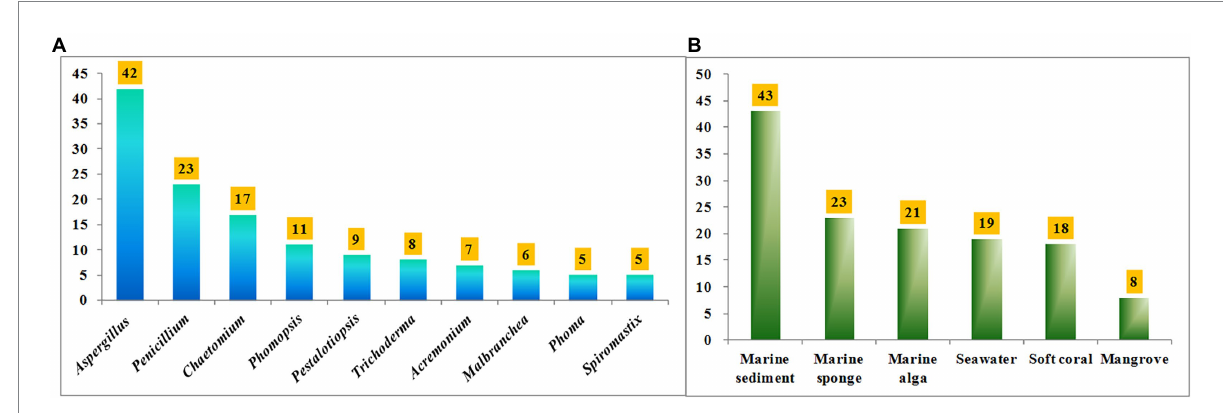
FIGURE 11 (A) Numbers of halometabolites from different marine-derived fungi; (B) Numbers of halometabolites from different sources of marine